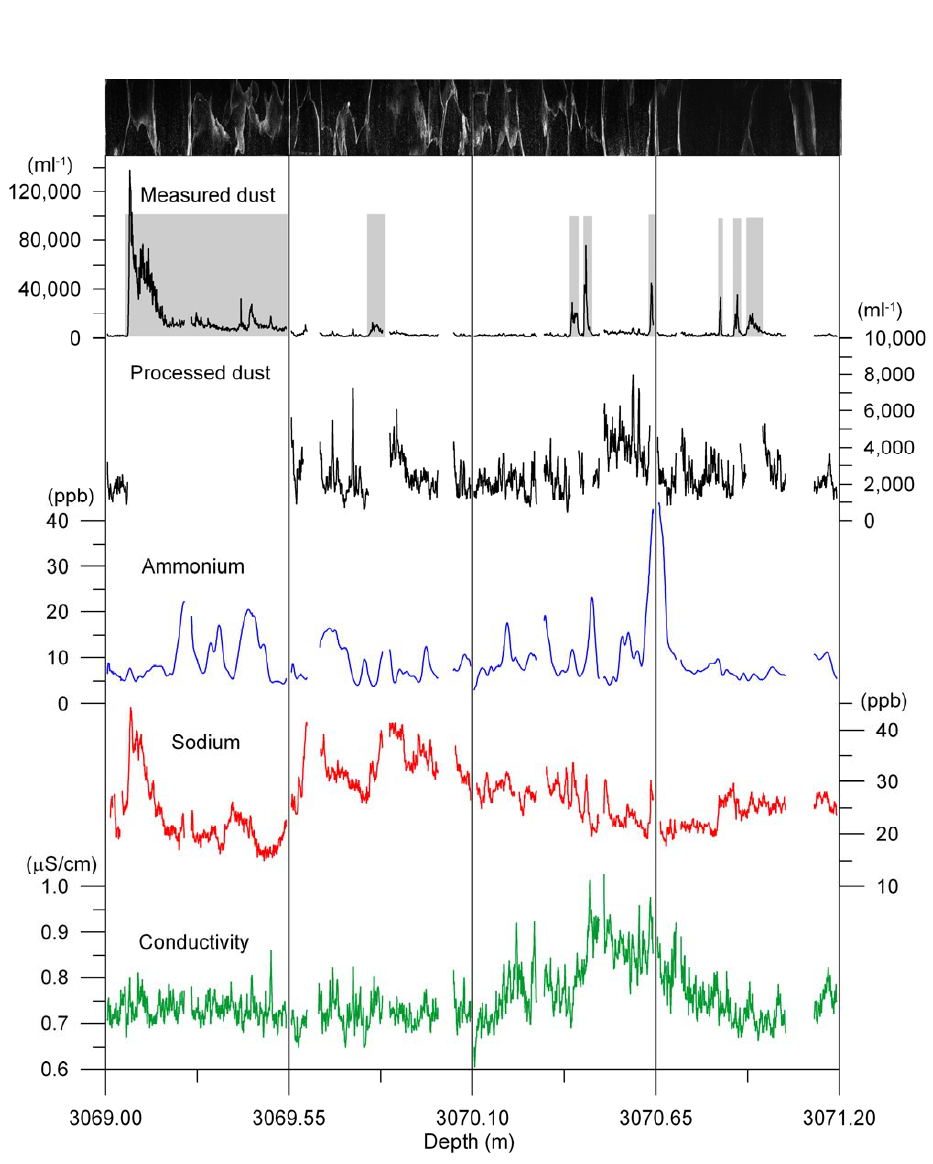
Fig. 3. Measured records of dust, ammonium, sodium, and conductivity from sample “A” shown together with the visual stratigraphy (top). The uppermost curve shows the measured dust profile including the contaminated sections that are indicated with gray bars. For the second dust curve, the contaminated sections are removed. Data gaps are caused by breaks in the core (that were removed), contamination issues (dust only), or analytical issues. Vertical lines indicate the 55cm sections of the analyzed